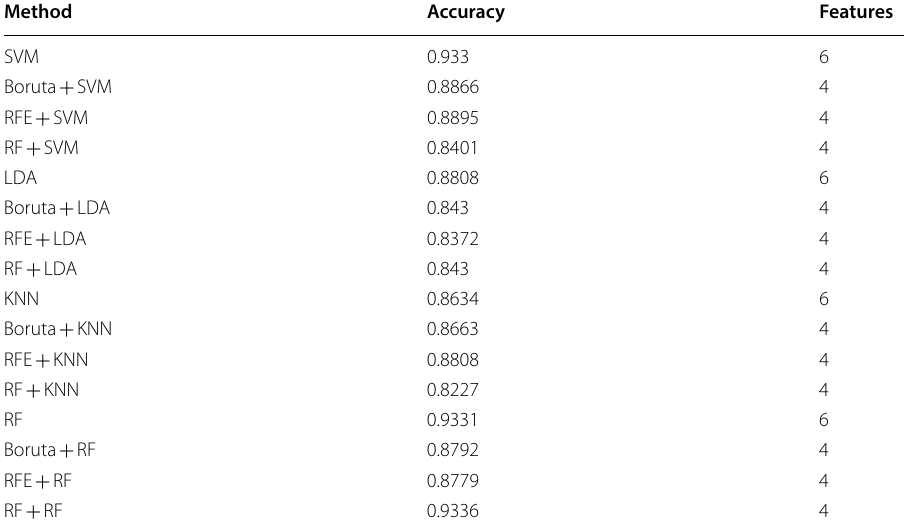
Table 10 Classification accuracy of different classifiers with car evaluation dataset